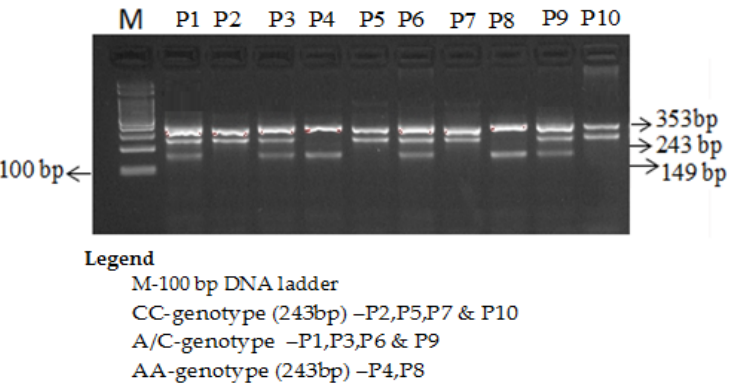
Figure 2. Genotyping of the VEGF rs699947 C/A using ARMS-PCR in T2D subjects. The mir1 28 rs11888095 C/T amplification products were separated by electrophoresis. Primers Fo and Ro of mir128 rs11888095 C/T resulted in a band of 458 bp to act as a control for DNA quality and quantity. Primers Fo and Ro amplify a wild-type allele (T allele), generating a band of 202 bp, and primers Fo and RI generate a band of 295 bp from the mutant allele (A allele)